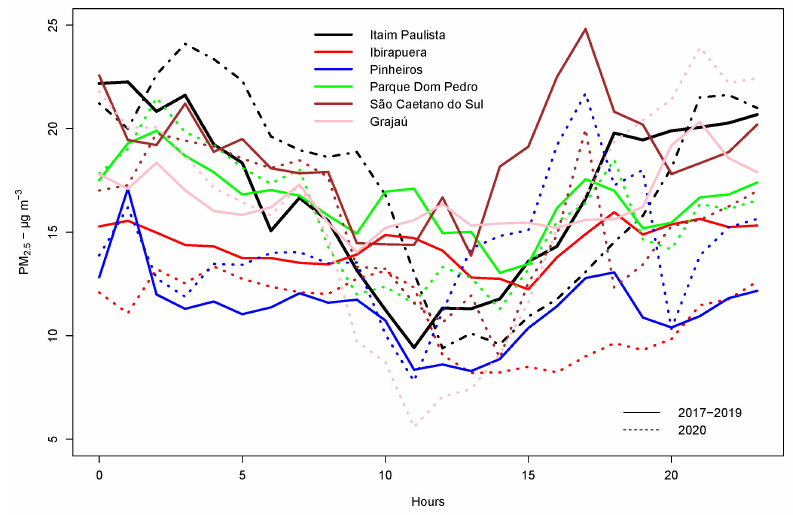
Figure 11. PM2.5 hourly concentration for MASP during April–May 2017–2019 (pre-pandemic) and 2020 (during the pandemic) from ground-level